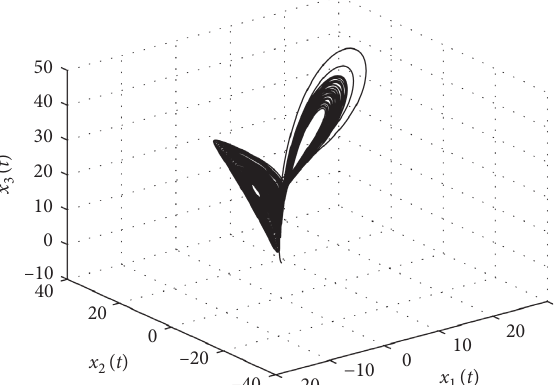
Figure 1: Chaotic behaviors of the fractional order uncertain Lorenz